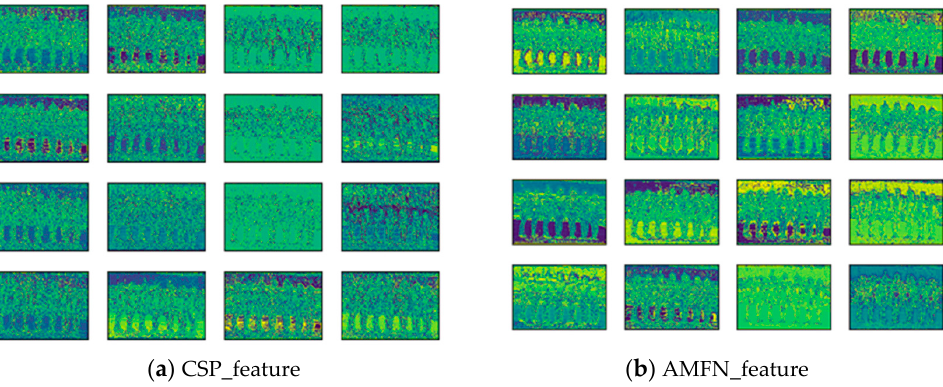
Figure 9. Comparison of feature extraction between old and new backbone networks. Under the feature extraction of the same layer, obviously, the features extracted by AMFN are more clear than those extracted by CSP (CSP_feature refers to the features extracted from CSP network, and AMFN _feature refers to the features extracted from AMFN network).